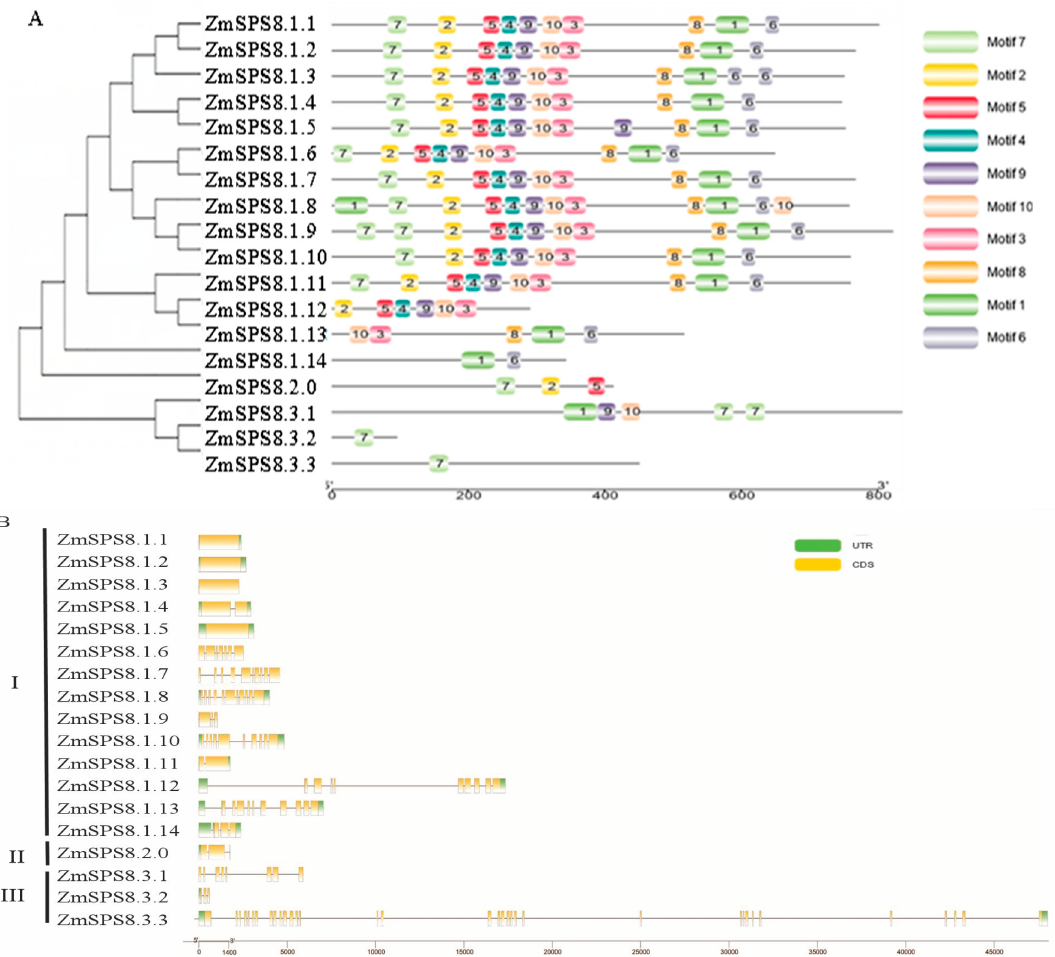
Figure 1. Phylogenetic relationships, conserved motifs, and gene structures of maize serine peptidase S8 family proteins. ( A ) Unrooted tree of 18 proteins and comparison of the conserved motifs of the 18 proteins. MEGA-X was used to construct the maximum-likelihood phylogenetic tree with 1000 replicates. Ten conserved motifs are shown in different colored boxes, and the details of all motifs are displayed in Supplementary File. ( B ) Exon–intron structures of 18 proteins. Yellow boxes represent exons, black lines represent introns, and the upstream/downstream regions of 18 genes are represented by blue boxes.